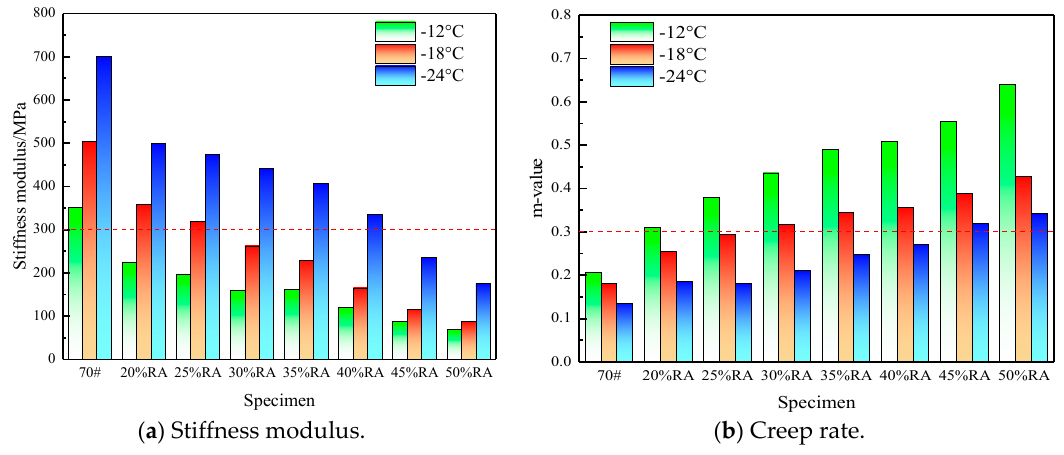
Figure 10. Low-temperature stiffness modulus and creep rate of high-content rubberized asphalt. ( a ) Stiffness modulus ( b ) Creep rate.